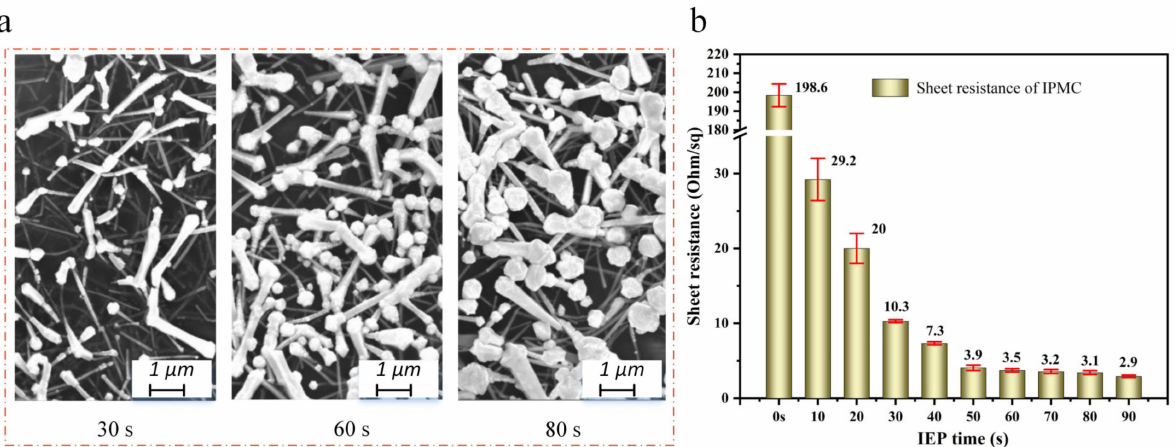
Figure 5. Effects of electroplating time on Au-shell-Ag-NW-based IPMC. ( a ) Micromorphology of IPMC with 30 s, 60 s and 80 s electroplating time, respectively. ( b ) Sheet resistance of IPMC with different electroplating